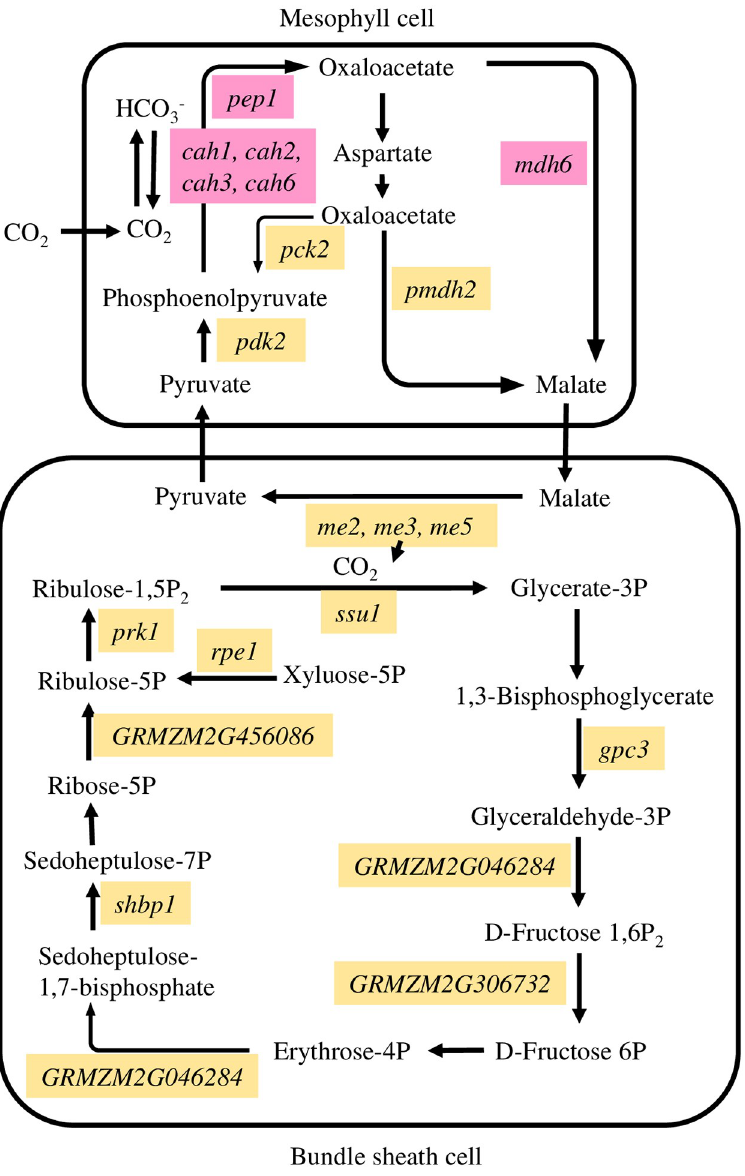
Fig 3. Schemetic drawing of carbon fixation in photosynthetic process (adapted from KEGG pathway zma00710) [61]. Associated genes found significant for crowding stress response are listed in italic in pink boxes for GSS2259P and yellow boxes for